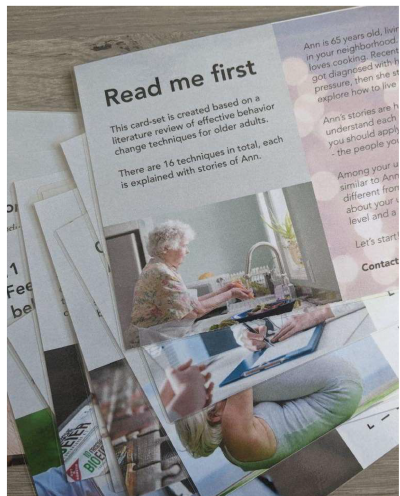
Figure 2. The card-set of the toolkit.